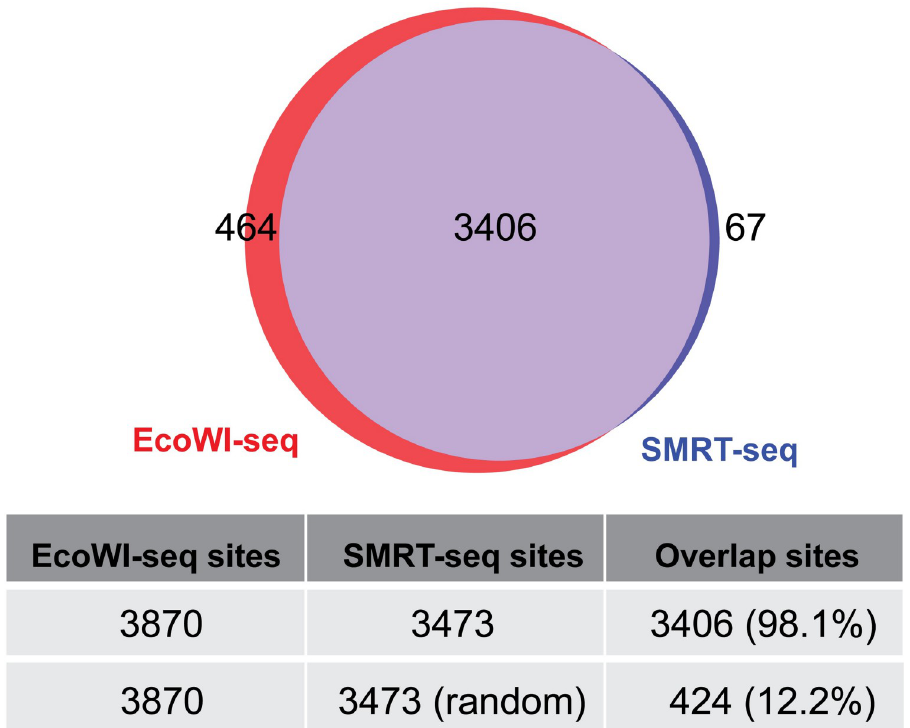
Fig 3. Validation of EcoWI-seq called PT modification positions in the WT Dnd+ Sen C87 strain. Venn plot showing the overlap of modified GpsAAC/GpsTTC positions identified using EcoWI-seq (red) and SMRT sequencing (blue). The numbers of called modified sites and overlaps were listed in the table below. The percentages of SMRT- sequencing sites overlapping with EcoWI-seq sites are listed in parentheses. Note that we also randomly chose 3473 positions from available GAAC/GTTC positions and this only led to a small percentage of overlap with EcoWI-seq modified positions.